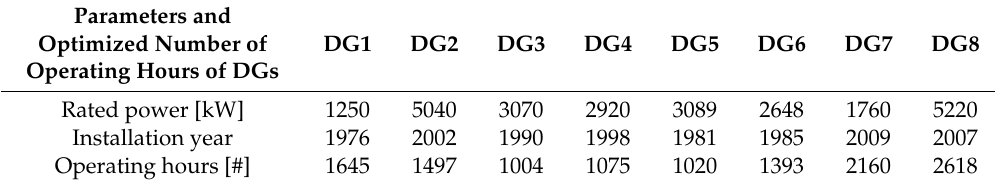
Table 4. PV and STC in twelve monthly optimizations.